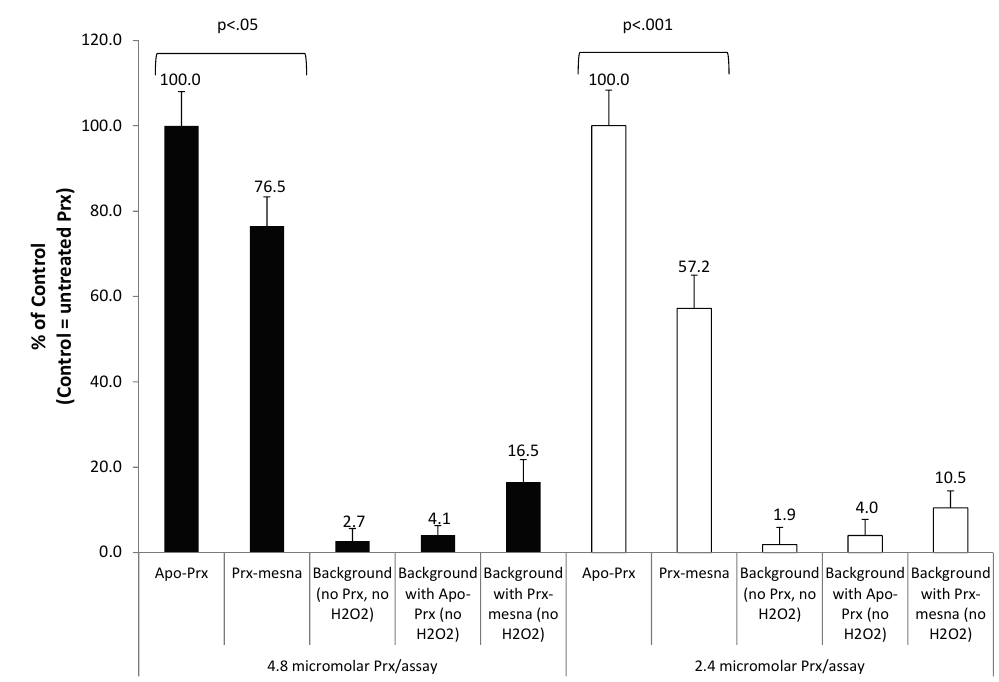
Figure 3. Effect of BNP7787 on Prx activity in vitro . ( A ) Prx enzyme assay (note that